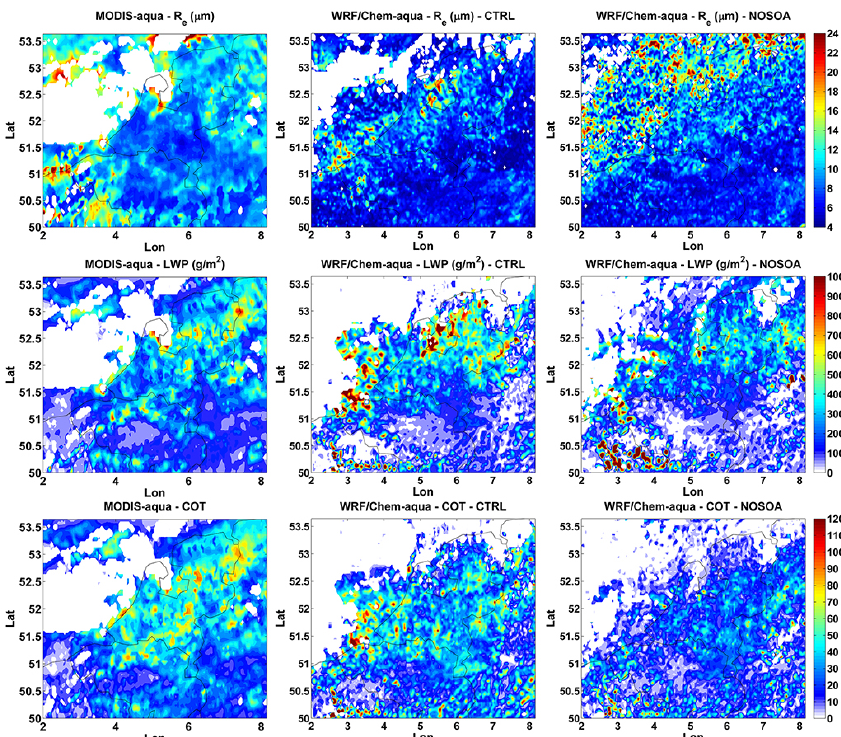
Figure 12. The 17–19 May 2008 averages of droplet effective radius at cloud top (first row), liquid water path (second row), and liquid cloud optical thickness (third row), retrieved using MODIS-aqua observations (first column), predicted by model in the references run (CTRL, second columns) and sensitivity test without SOA (NOSOA, third